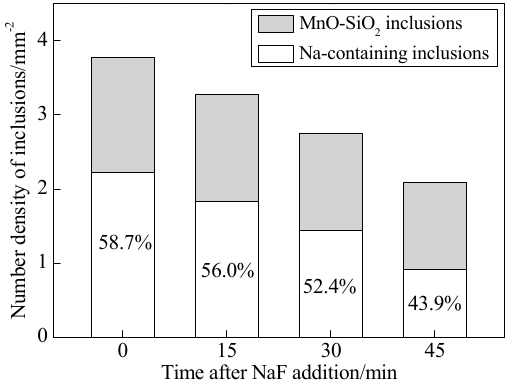
Figure 13. Quantity of inclusions at di ff erent times after NaF addition in Heat D.